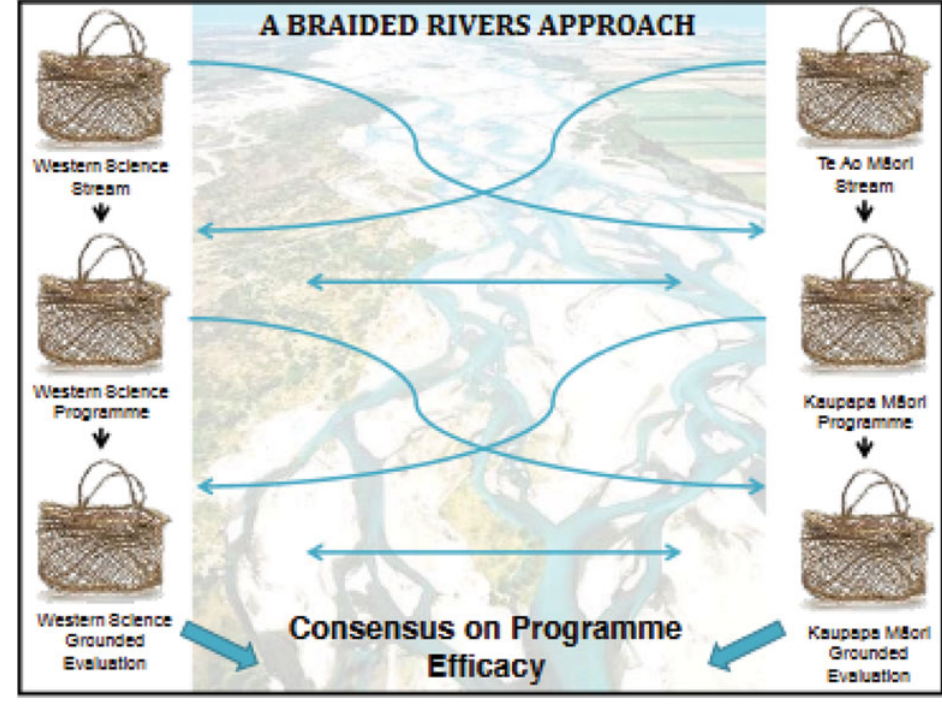
He Awa Whiria: A Braided Rivers Approach (Ministry of Social Development,